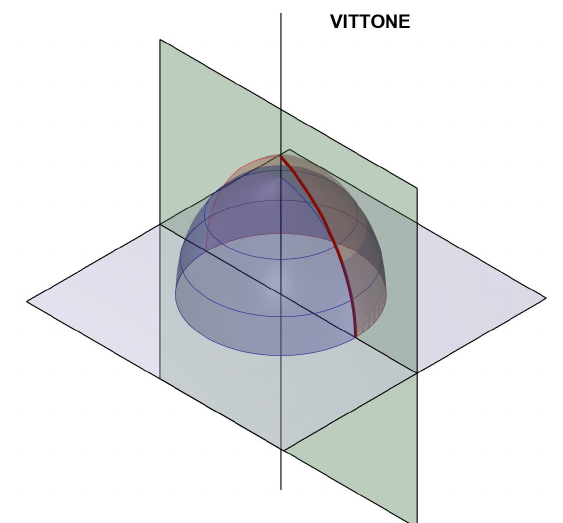
Figure 11. Napoli, S. Maria di Costantinopoli Church: overlap to Serlio model